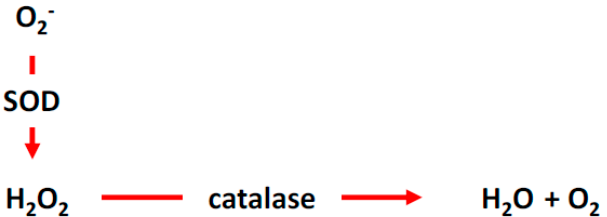
Figure 2. ROS cycle and homeostasis. Superoxide is converted the hydrogen peroxide, which is then catalyzed by catalase to water and molecular oxygen. SOD, superoxide dismutase.